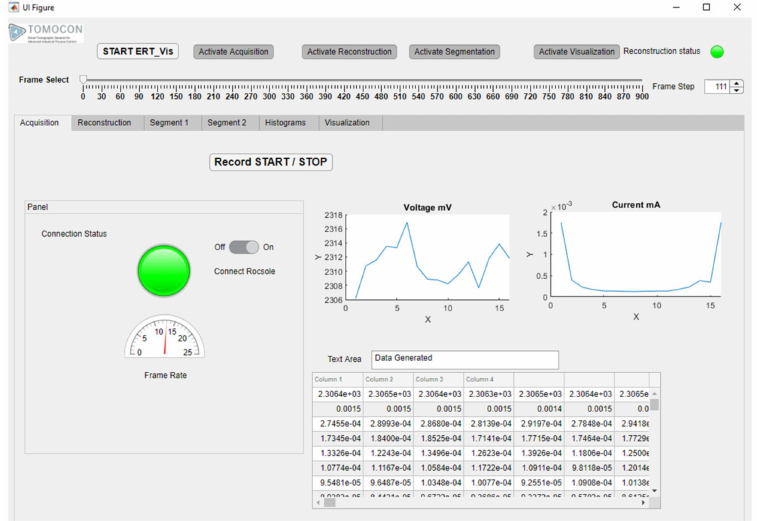
Figure 5. ERT-Vis: Data acquisition module tab at initial